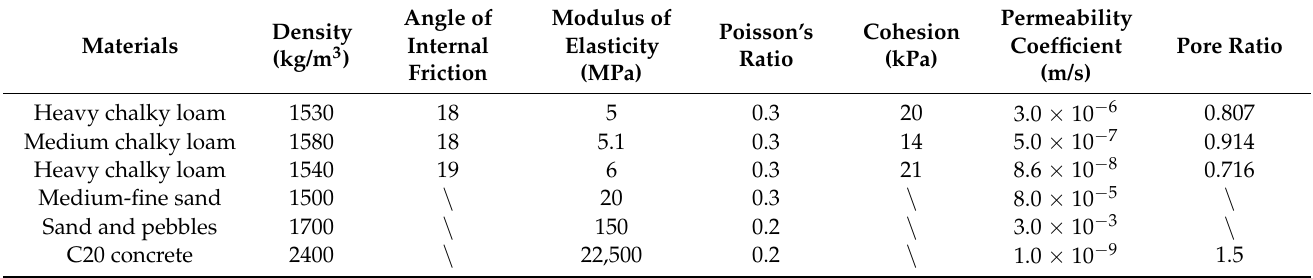
Table 1. Suggested values for physical parameters of soil layers and structural materials in the site